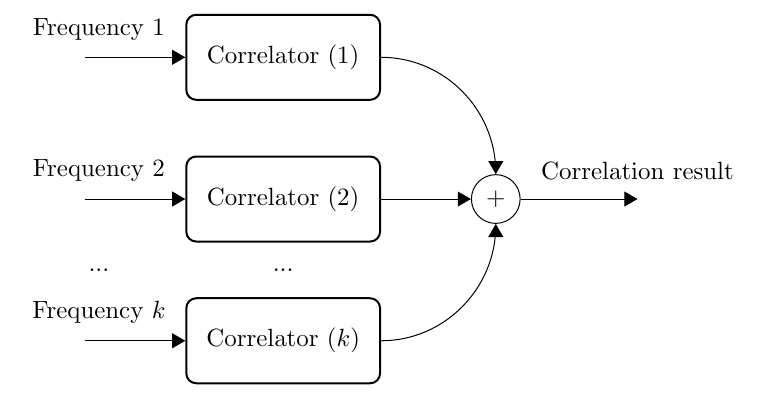
Figure 7. Correlation of multiple ( k ) frequency